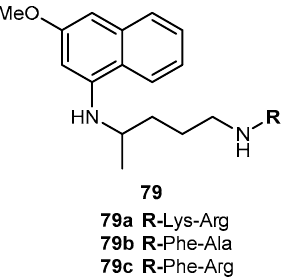
Figure 33. Dipeptide prodrugs of 6 tested against trypanosomiasis.